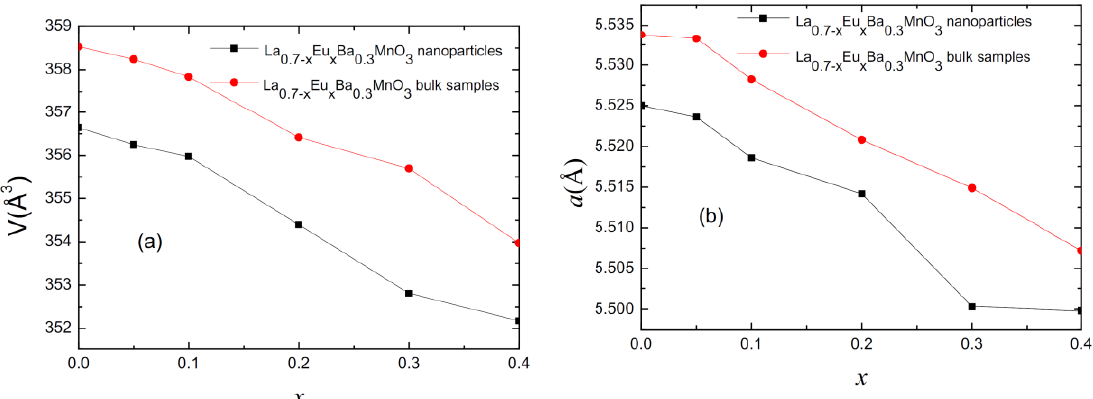
Figure 2. ( a ) Plot of cell volume for polycrystalline bulk and nano-sized samples. ( b ) Plot of cell parameter “ a ” for polycrystalline bulk and nano-sized samples.